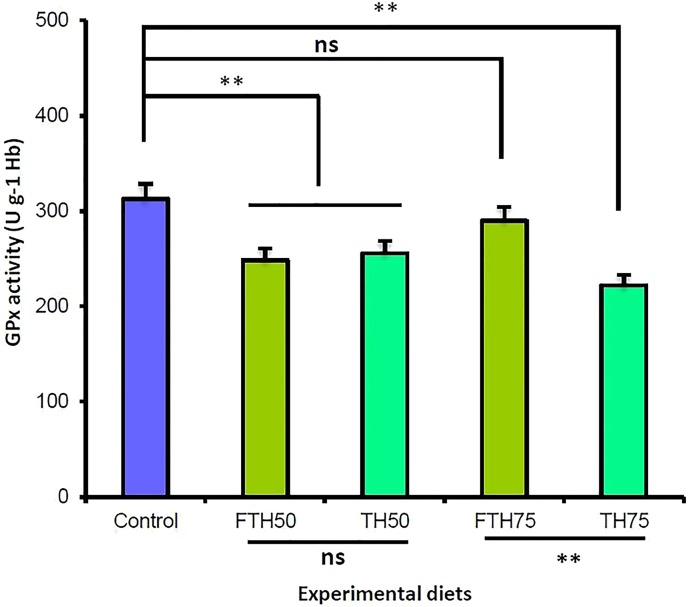
Glutathione peroxidase (GPx) activities of juvenile barramundi fed fermented and non-fermented tuna hydrolysate (TH) at various inclusion levels.Post-ANOVA Duncan’s multiple comparisons test was applied to compare GPx activities of fish fed on four experimental diets to the control. Values are the mean of three replicate tanks per treatment ± standard error. The significant difference was considered at p < 0.05. (**: significant; ns: non-significant).